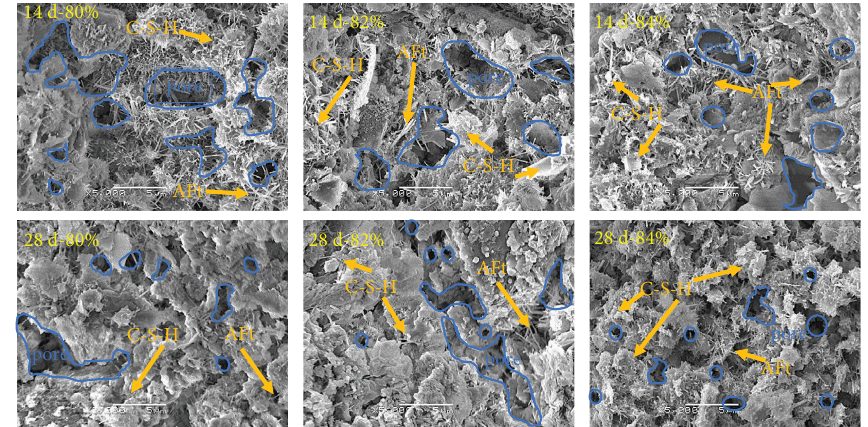
Figure 12: Microstructure of CGGCFB with diferent mass concentrations at diferent